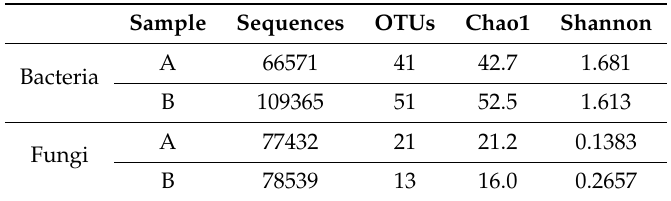
Table 1. Alpha diversity indices (Chao1 and Shannon) for bacterial and fungal communities, in T1(water kefir) mini-silos, before (A) and after (B)